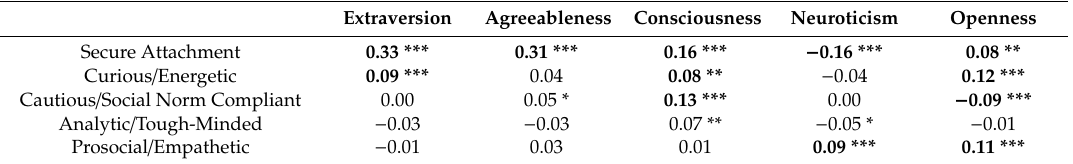
Table 2. Partial Correlations (controlling for sex and age).